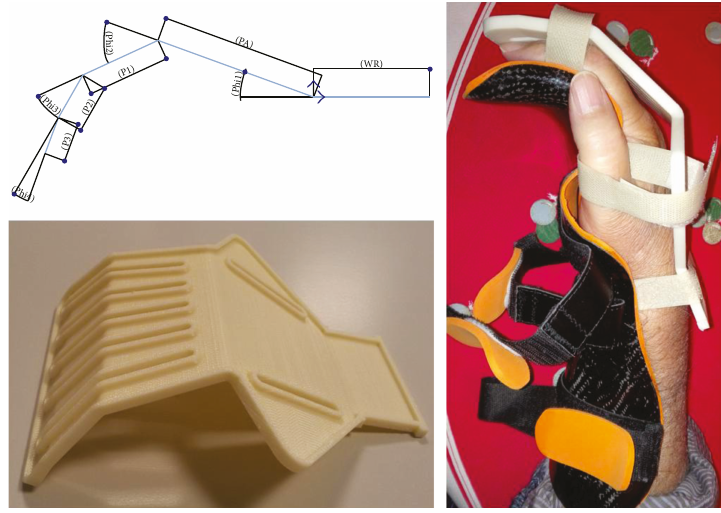
Figure 8: Support version V2: design, fabrication, and use.